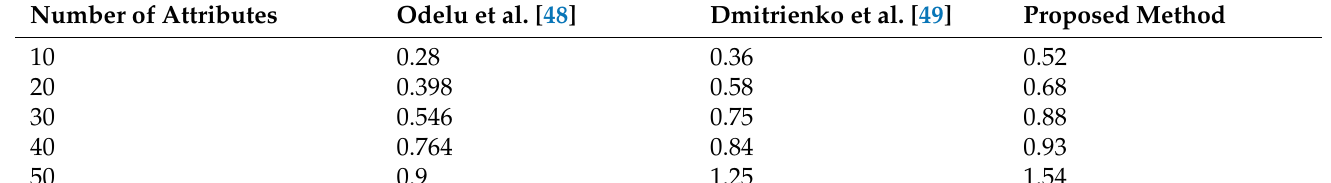
Table 8. Comparison of decoding time in IoT device.